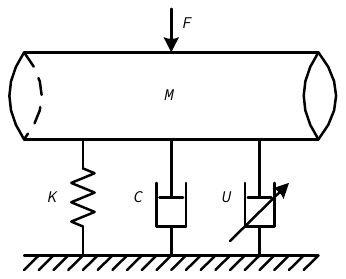
Figure 6. Schematic diagram of pipeline system.